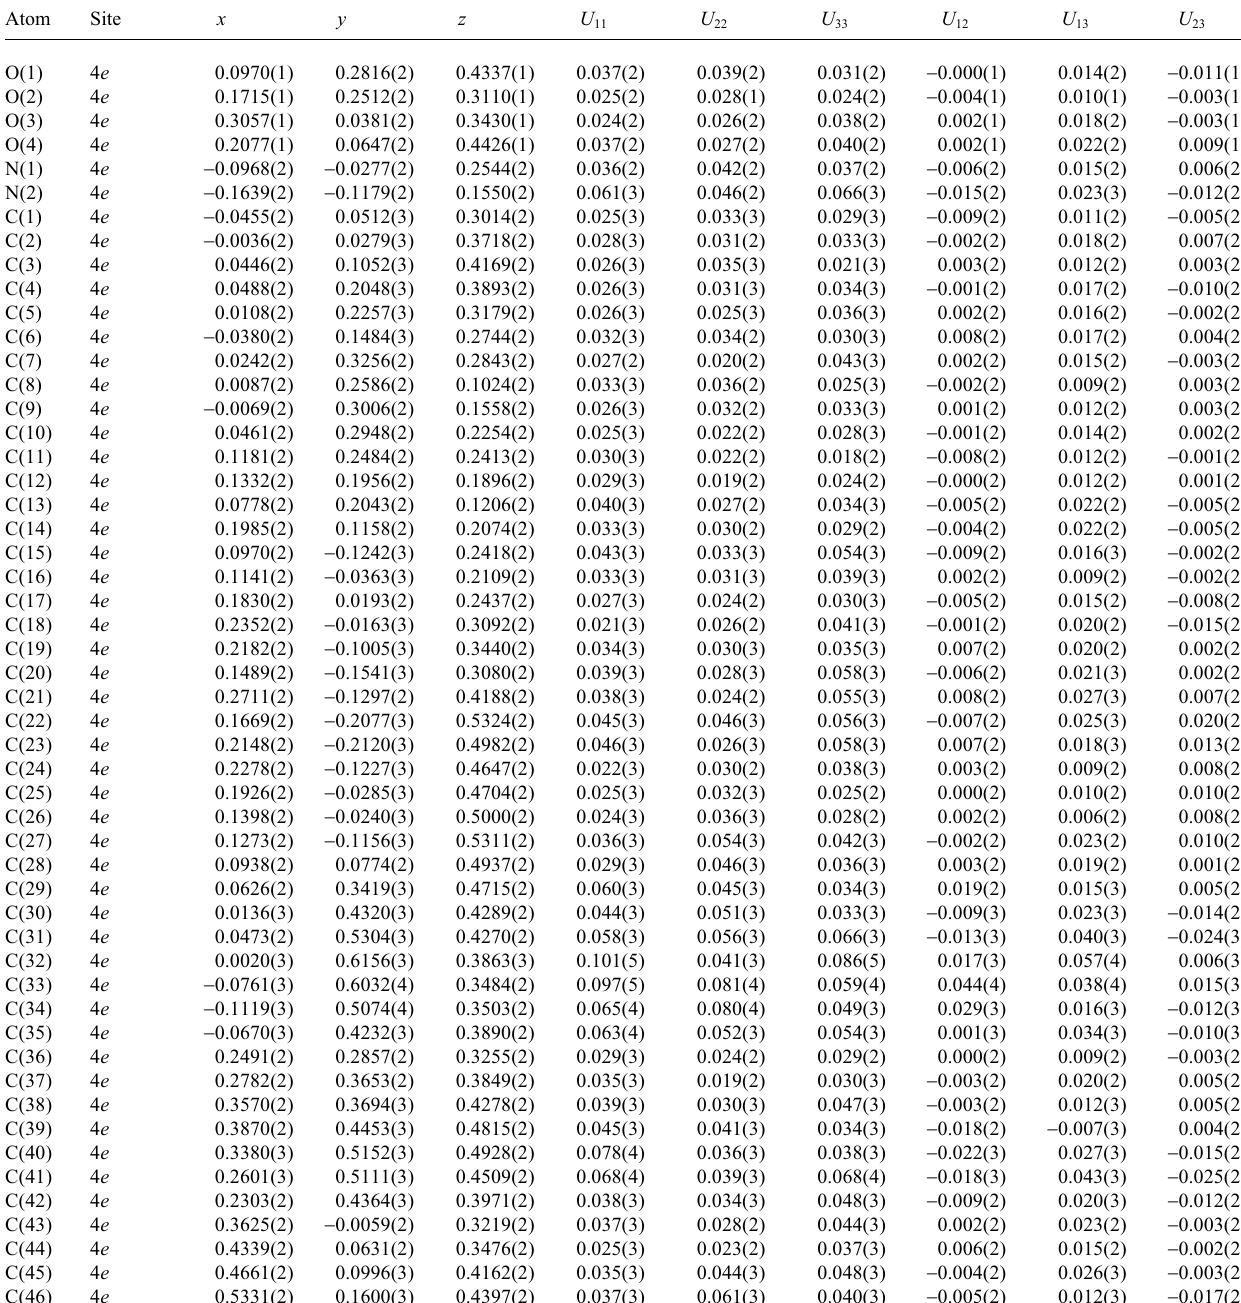
Table 3. Atomic coordinates and displacement parameters (in Å 2